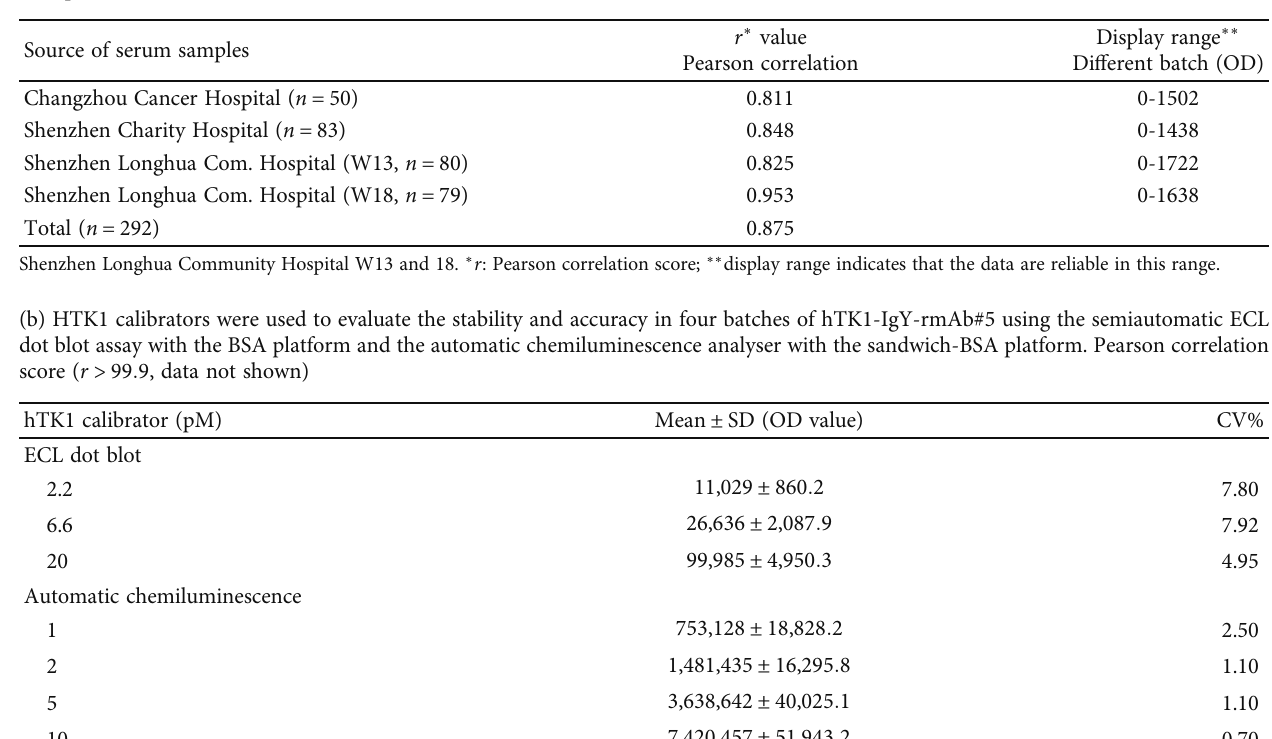
Table 4: Determination of the correlation score, stability, and accuracy of hTK1-IgY-rmAb#5